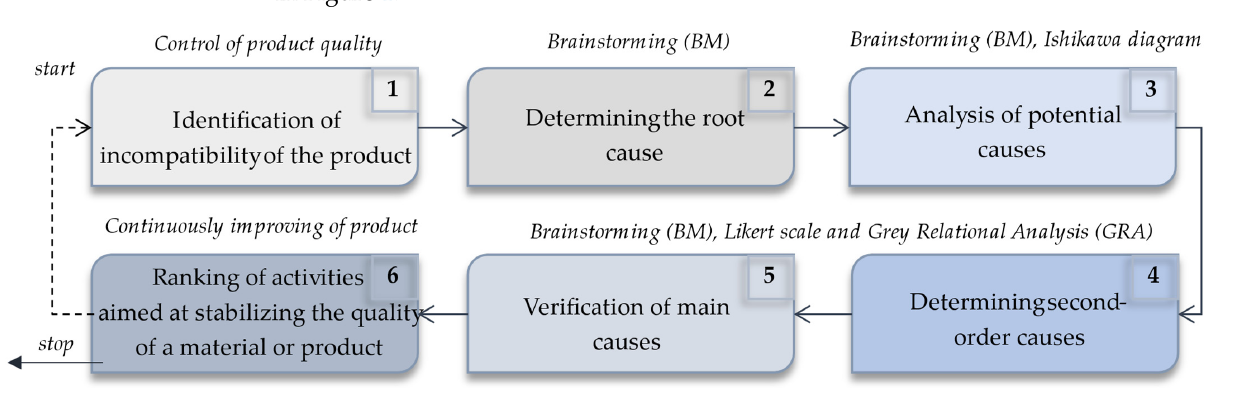
Figure 1. General concept of